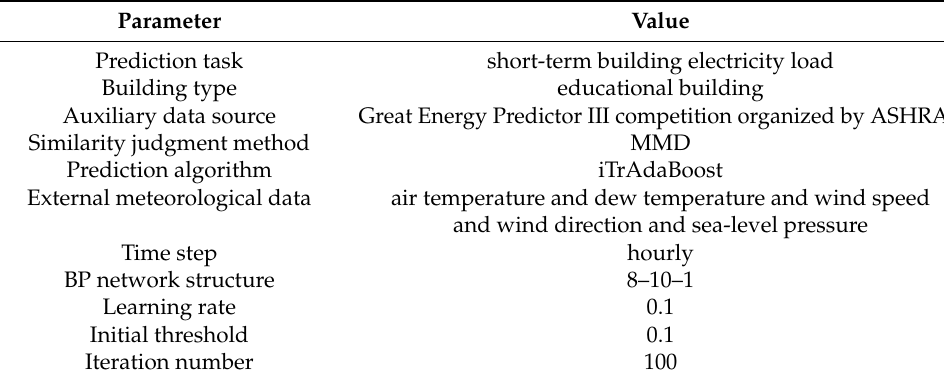
Table 1. Main parameter settings for the case